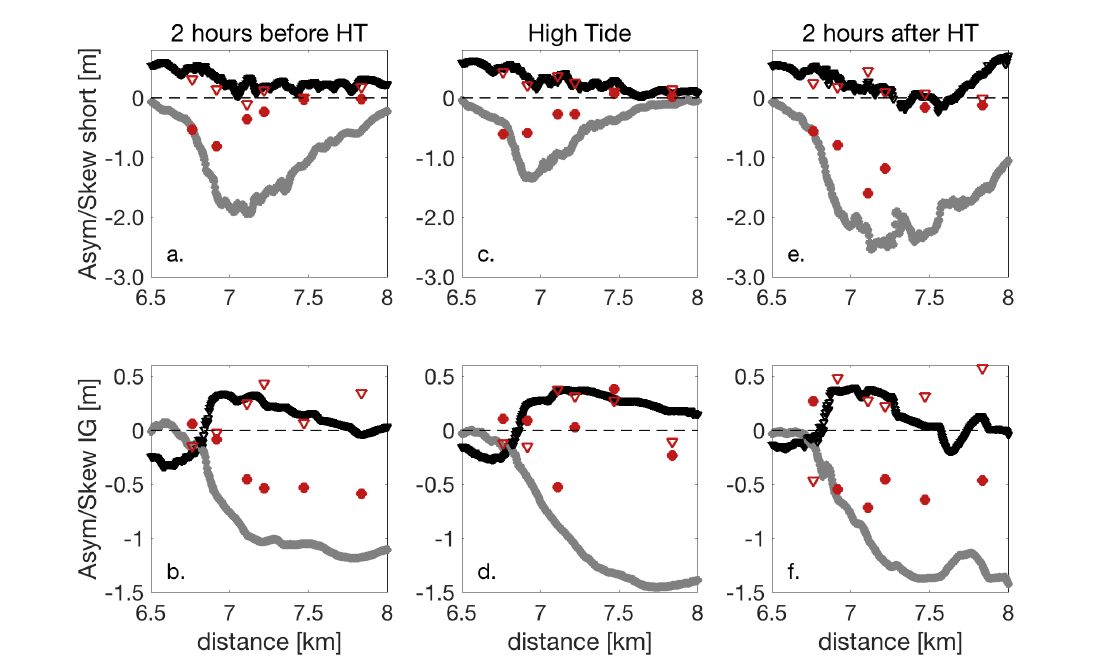
Figure A3. Observed wave asymmetry (red dots) and skewness (red triangles) compared to modeled wave asymmetry (gray) and skewness (black) from 2 h before until 2 h after high tide (HT) for flooding 1. The North Sea is to the left and the Wadden Sea to the right in this